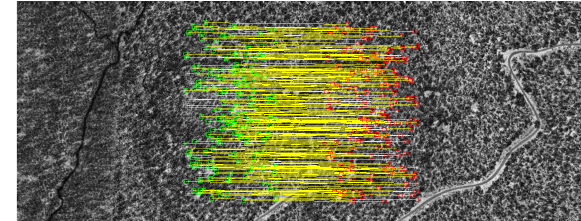
Figure 11: Matches for descriptor based only on intensity data